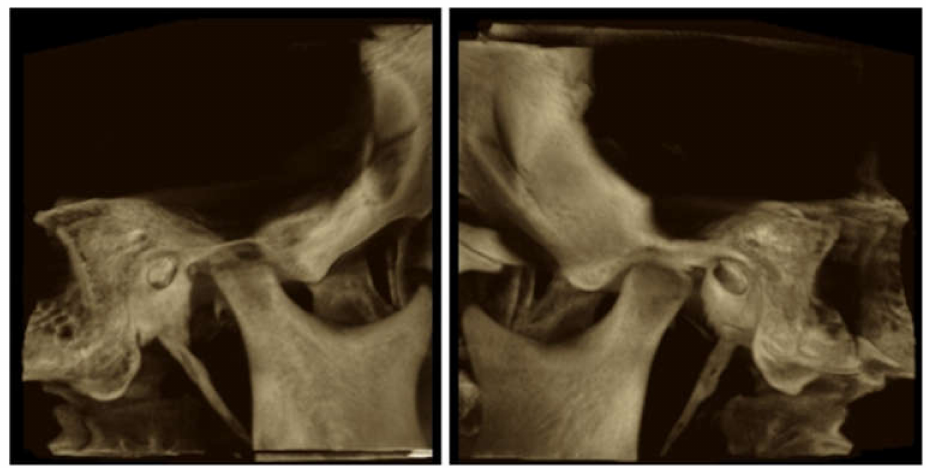
Figure 4. CBCT-condylar lysis and condylar remodeling.